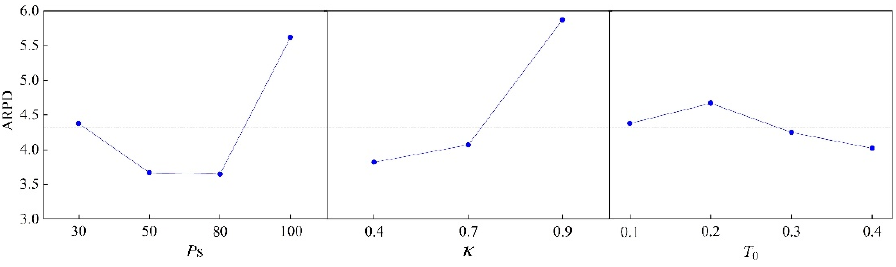
Figure 7. Main effects plot of the parameters for DMA.